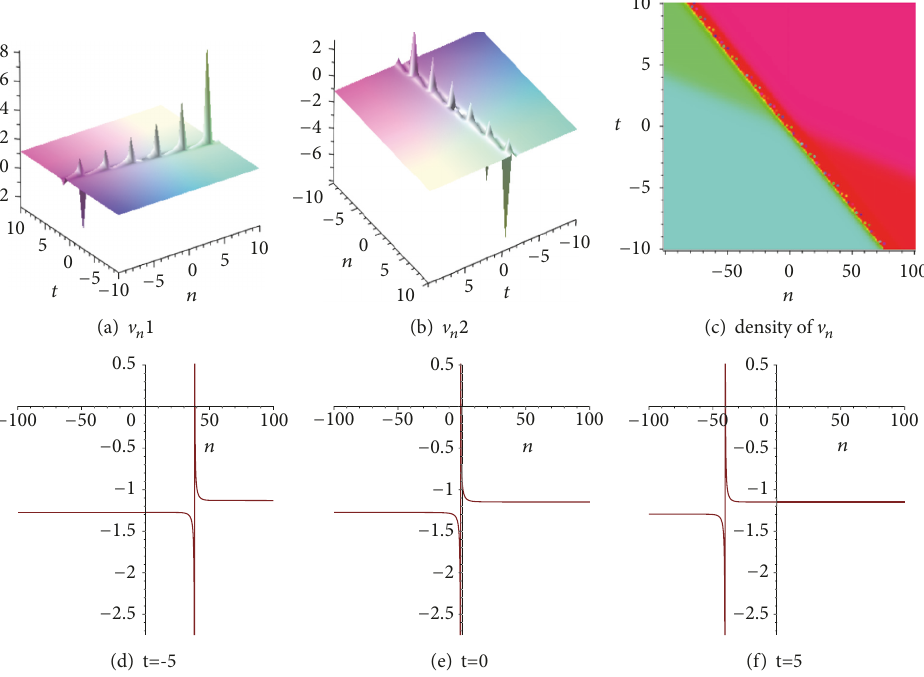
Figure 2: A structure of soliton solution for V 𝑛 in (66) with 𝜆 1 = 0.5,𝜆 2 = 2, 𝛾 1 = 1,𝛾 2 = −1 . Figures (a) and (b) are three-dimensional graphs of V 𝑛 . Figure (c) is the density plot of V 𝑛 and Figures (d), (e), and (f) are structures of the solution V 𝑛 at different